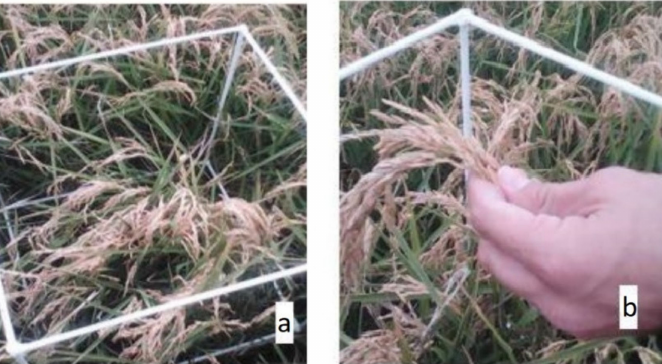
Figure 5. Procedure for obtaining point yield data: field sampling frame ( a ) and rice grains’ detail ( b